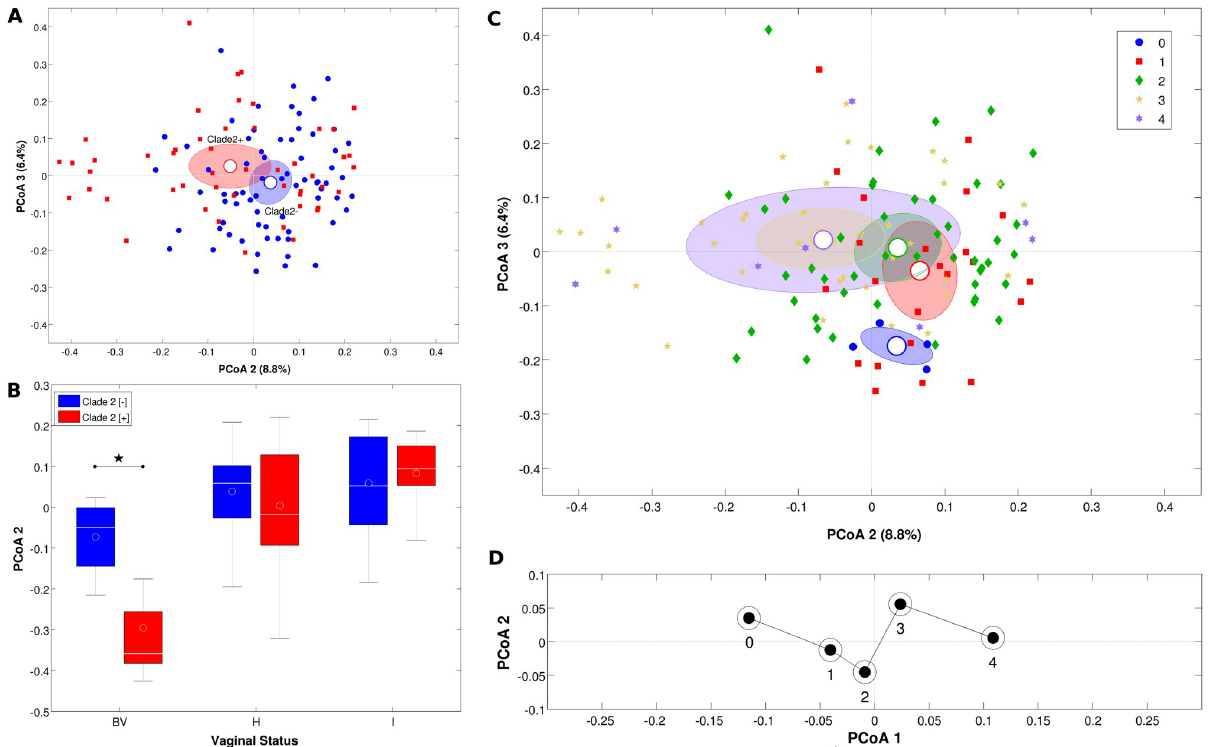
Fig 1. A ) Principal Coordinate Analysis (PCoA) plots based on the unweighted Unifrac distance among samples clustered on the presence of GV clade 2 . Each point represents a sample, colored according to the experimental category (blue: Negative, red: Positive). Ellipses are 95% SEM-based confidence intervals, and centroids represent the average coordinate per category. The second and the third coordinates are represented. B) Boxplots of the distributions of PCoA coordinate 2 on the unweighted Unifrac distances for presence/absence of GV clade 2, with samples divided according to their vaginal status (by Nugent score) . Asterisk indicates statistical significance (p < 0.05, adonis test) C) PCoA plot based on the unweighted Unifrac distance among samples clustered according to the number of GV clades present in each sample . Each point represents a sample, which is colored according to the experimental category. Ellipses are 95% SEM-based confidence intervals, and centroids represent the average coordinate per each category. The second and the third coordinates are represented. D) Trajectory plot of the PCoA centroids obtained from the first and second coordinate of the PCoA analysis of the weighted Unifrac distances